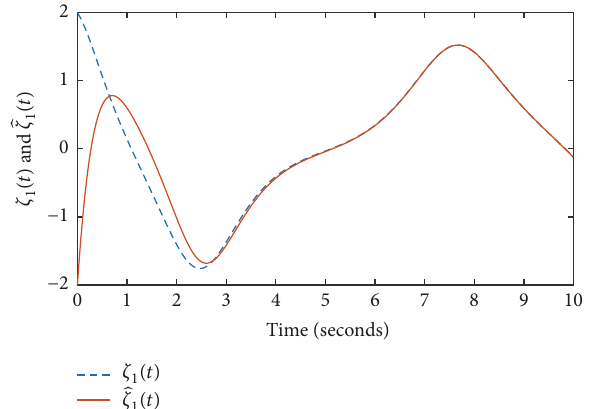
Figure 2: Synchronization between 𝜁 1 (𝑡) and